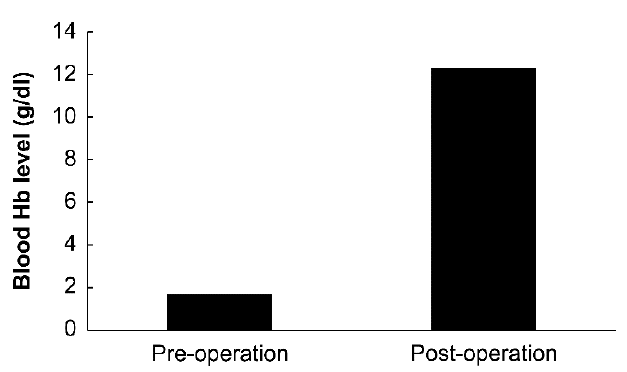
Figure 5. Evaluation of menorrhagia and dysmenorrhea before and after surgery using a visual analog scale.